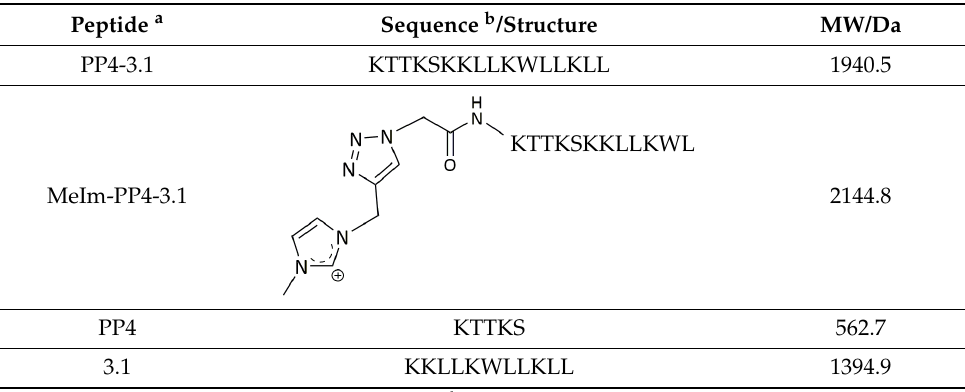
Table 1. General data on the peptide constructs synthesized.